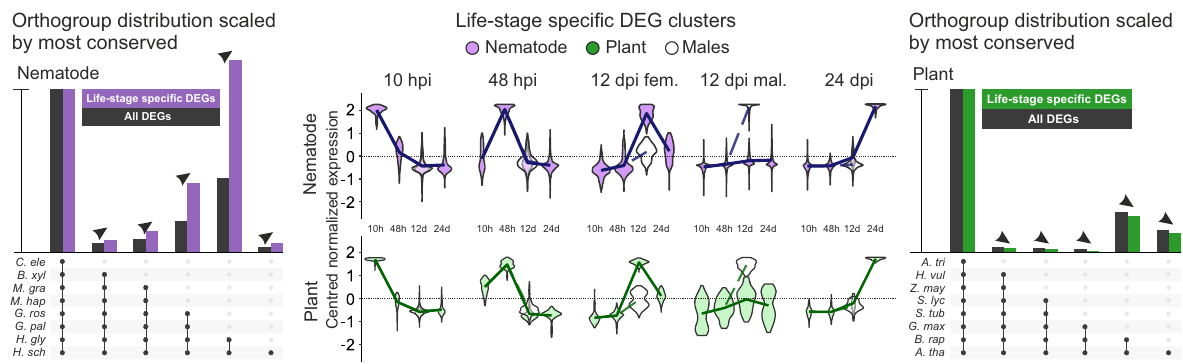
glycines , and H. schachtii ) and eight plant species (right - Amborella trichopoda, Hordeum vulgare , Zea mays , Solanum lycopersicum, S. tuberosum , Glycine max , Brassica rapa (ssp. rapa ) and A. thaliana ). Arrowheads indicate a proportional increase or decrease compared to all differentially expressed genes (DEGs, black). The probability <0.05 was empirically derived (from 1000 random samples of equal-sizedsubsets) for all fi ve categories with a proportionalincrease (in the